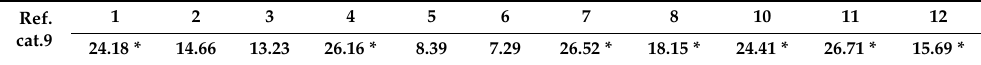
Table 5. Regression coe ffi cients for all dummy variables included in 2a